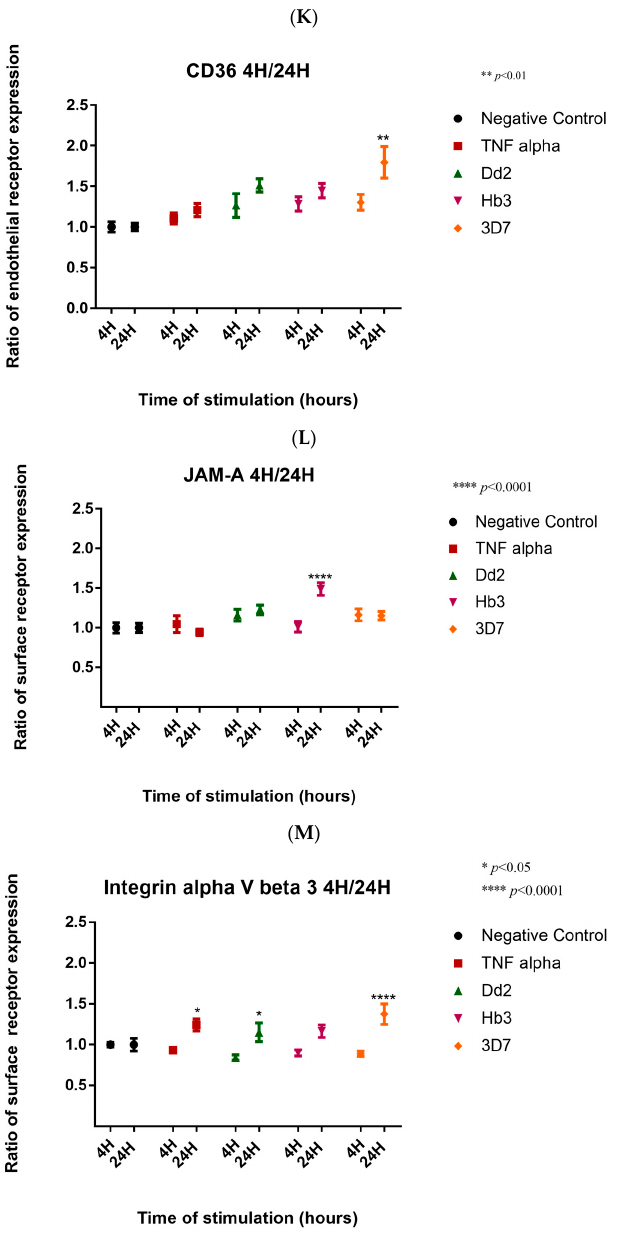
Figure 2. Cell receptor expression levels. Flow cytometry levels of receptors PECAM-1, VCAM-1, ICAM-1, EPCR, CD36, N-cadherin, JAM-A, Integrin alpha V beta 3, and ICAM-2 in HBMEC, when stimulated with Dd2, HB3, and 3D7 strains of P. falciparum parasites. Levels of surface expression of ( A ) PECAM-1, ( B ) VCAM-1, ( C ) ICAM-1, ( D ) ICAM-2, ( E ) CD36, ( F ) EPCR, ( G ) JAM-A, ( H ) N- cadherin, and ( I ) Integrin α V β 3, and expression on endothelial cells when in the presence of stimulation with TNF- α and P. falciparum parasites strains for 4 h and 24 h of activation, respectively.